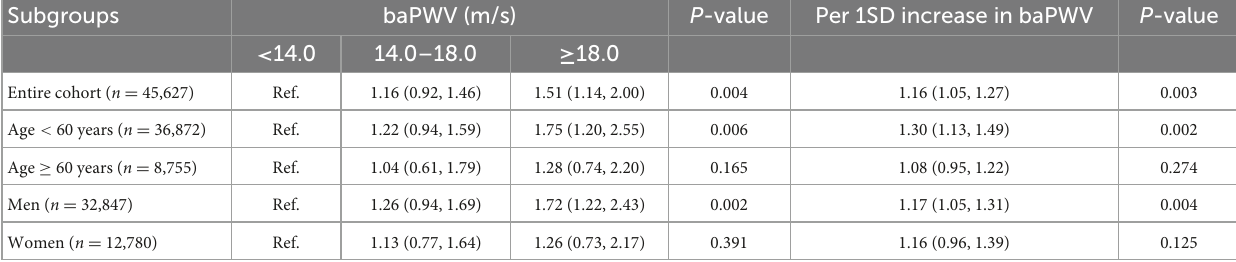
TABLE 2 Adjusted hazard ratios (95% CI) of cancer according to brachial-ankle pulse wave velocity (baPWV). Subgroups